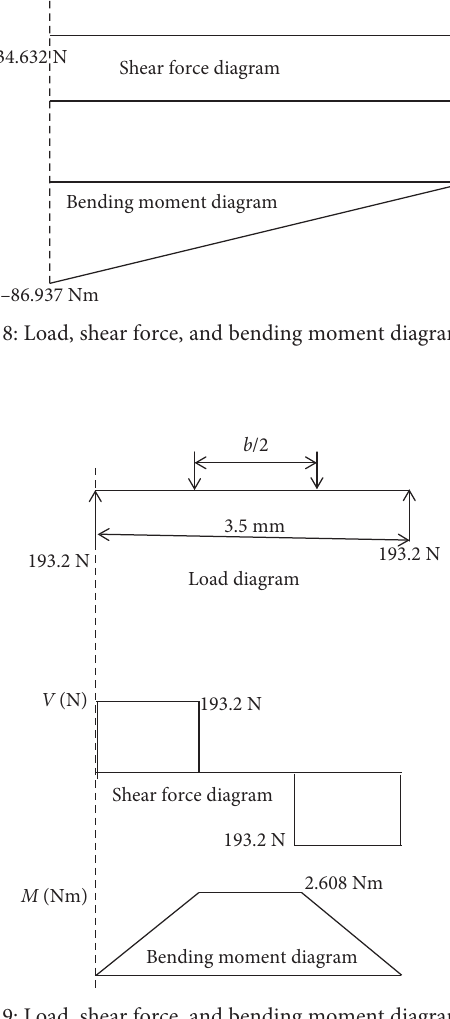
Figure 9: Load, shear force, and bending moment diagrams of the pivoting pin.